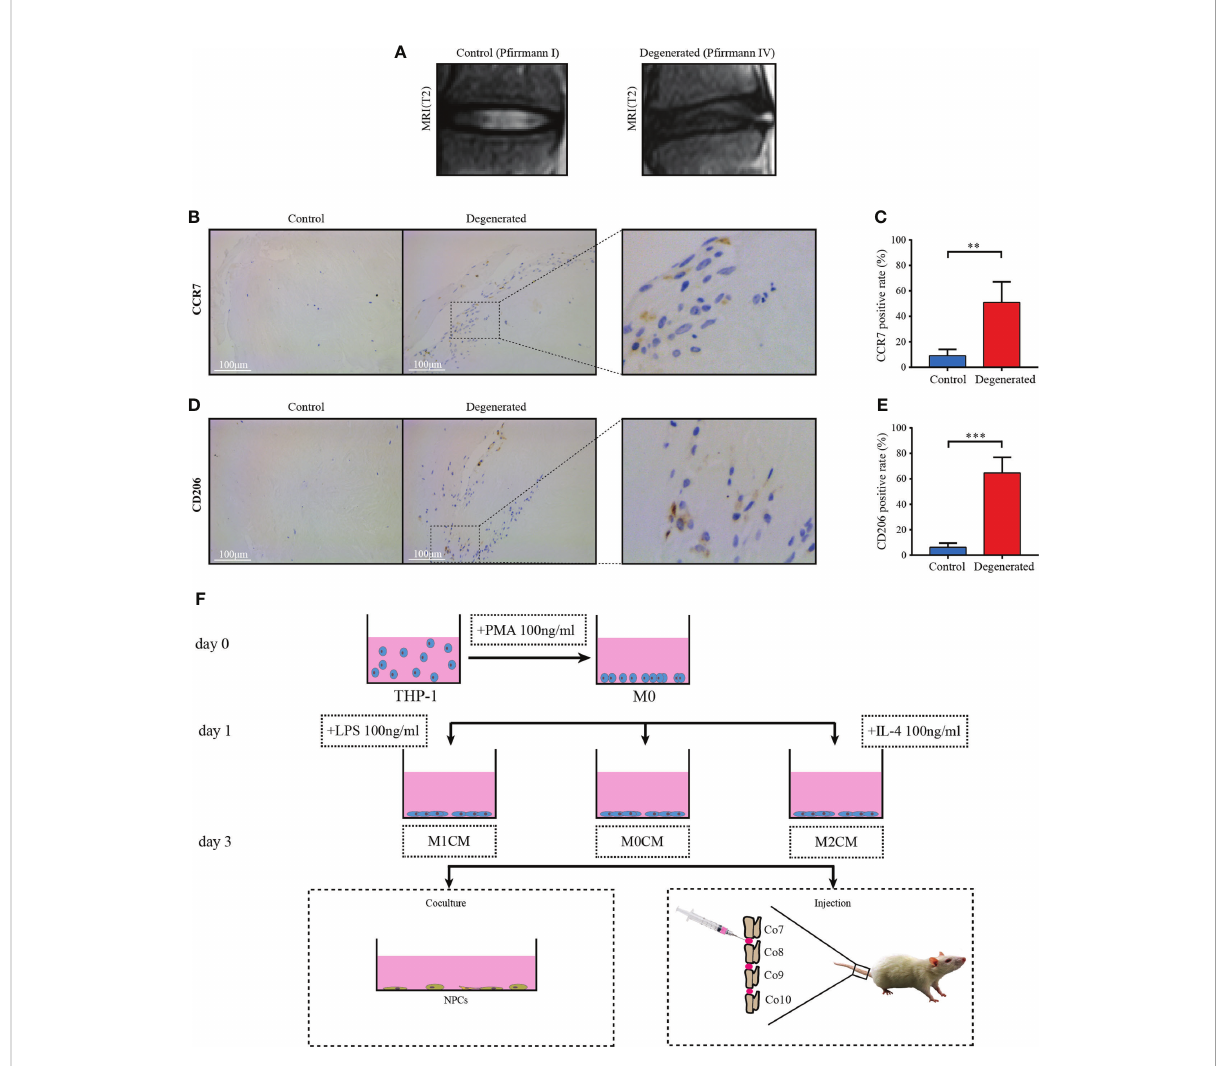
FIGURE 1 Macrophage accumulation and polarization in human IVD tissues. (A) Representative MR images showing normal (P fi rrmann grade I, n = 5) and IDD samples (P fi rrmann grades III-V, n = 8), respectively. (B) Representative images showing the immunolocalization of CCR7-positive cells in human normal IVD tissues; (C) Comparison of the proportion of positive cells corresponding to normal and degenerated IVD samples. (D) Representative images showing the immunolocalization of CD206-positive cells in human IDD tissues, and (E) Comparison of positive cells corresponding to normal and IDD samples. The data were analyzed using Mann – Whiney U test. **p < 0.01; ***p < 0.001. Data are shown as mean ± SD. IVD, intervertebral disc; IDD, intervertebral disc degeneration. (F) Flow diagram of harvesting conditioned medium (CM) and grouping process of CM in vitro and in vivo